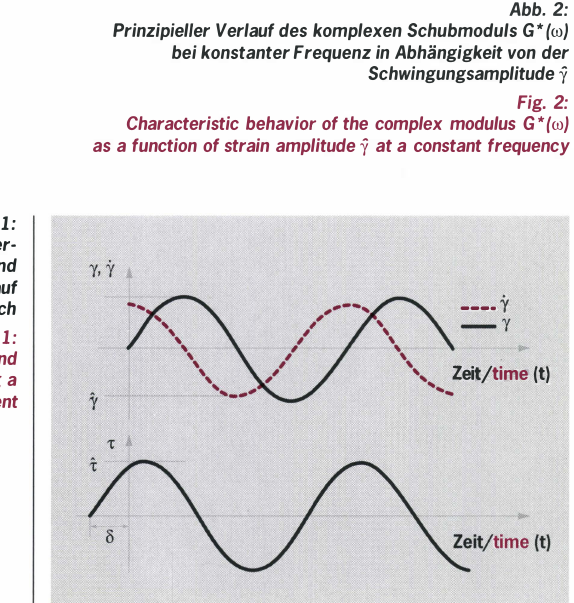
Characteristic behavior of the complex modulus G * (w} as a function of strain amplitude y at a constant